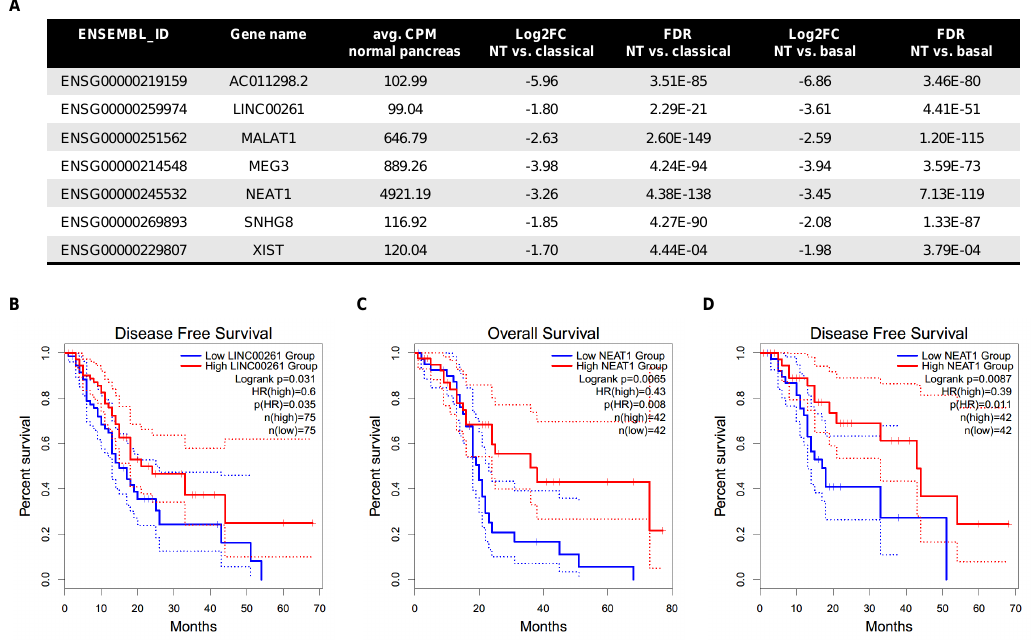
Figure 2. Expression and prognostic relevance of highly abundant lincRNAs. ( A ) Table shows the expression and regulation ( | log 2 FC | > 1; FDR < 0.05) of highly expressed lincRNAs (avg. CPM > 99 in normal pancreas). ( B , D ) Overall and disease-free survival analysis (OS and DFS, respectively) based on lincRNA expression was performed on either both, basal and classical TCGA PAAD samples together or separately using GEPIA2 ([36]). Log-rank test (Mantel-Cox) was used for hypothesis testing. The cox proportional hazard ratio (HR), logrank p -value and the 95% confidence interval information is included in the graphs. ( B ) In general, low expression of LINC00261 is associated with worse DFS of PDAC patients. ( C , D ) Low expression of NEAT1 is specifically associated with a poor OS ( C ) as well as DFS ( D ) in the classical